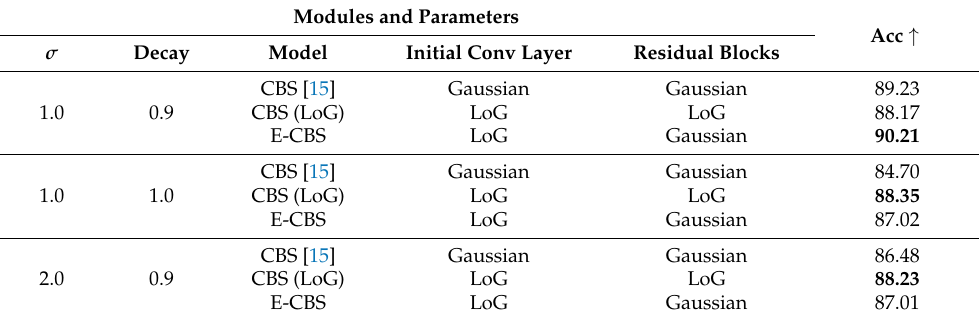
Table 5. Comparison of the proposed E-CBS and CBS (LoG) against the CBS [15]. Modules and